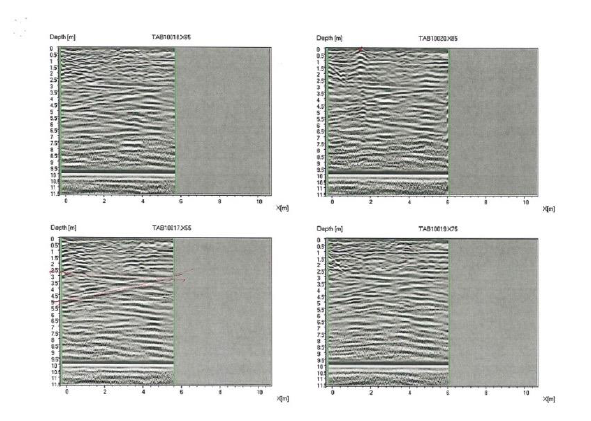
Figure 6. B-scan raw profile (GPR). and B-scan focused using the algorithm Diffraction Summation.